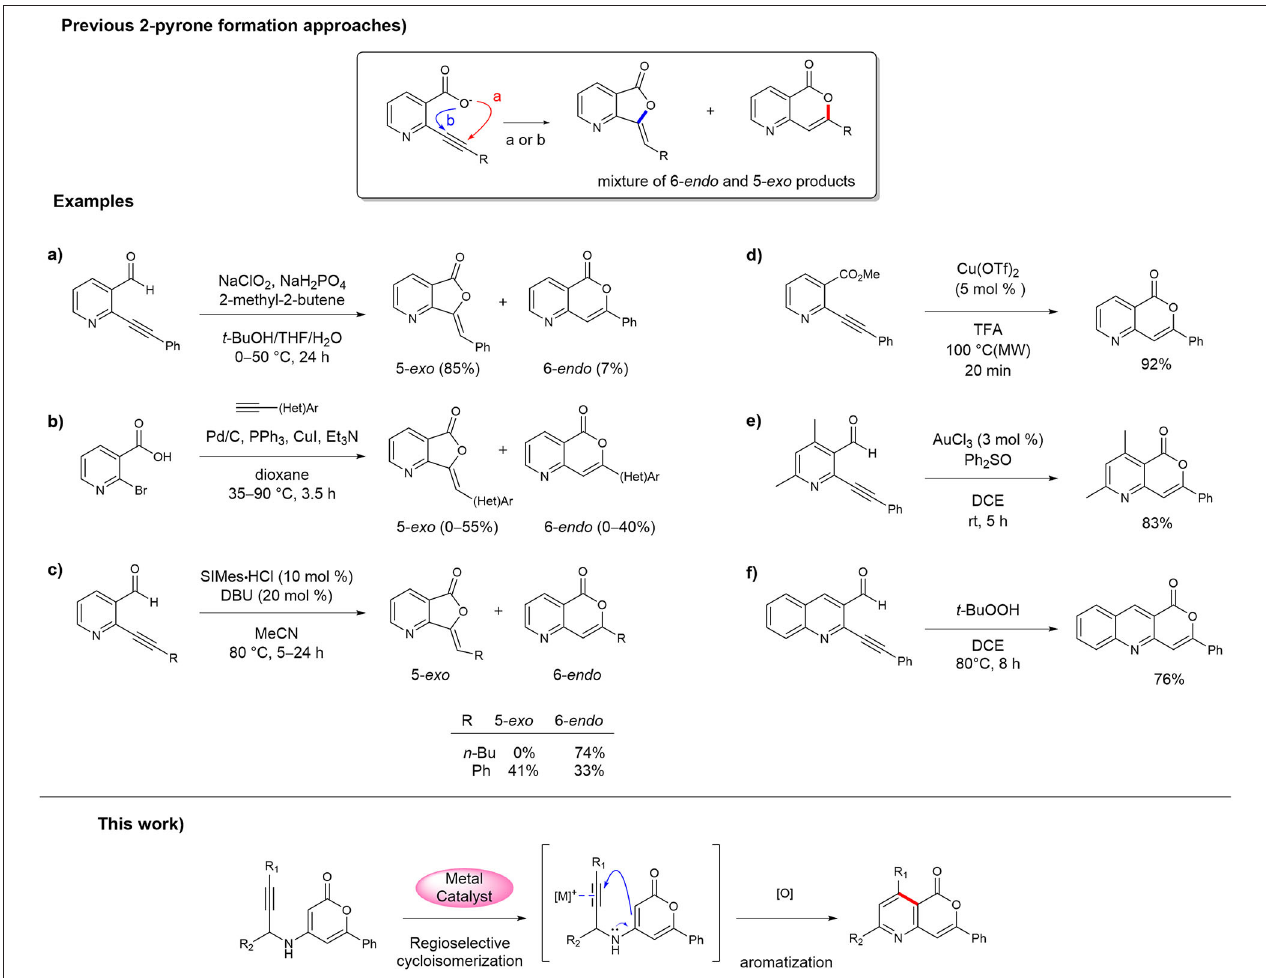
FIGURE 1 | Approaches for the synthesis of 5-azaisocoumarins. (a) Li’s synthesis of 5-azaisocoumarins; (b) Queiroz’s synthesis of 5-azaisocoumarins; (c) Youn’s synthesis of 5-azaisocoumarins; (d) Bihel’s synthesis of 5-azaisocoumarins; (e) Sarkar’s synthesis of 5-azaisocoumarins; (f) Singh’s synthesis of